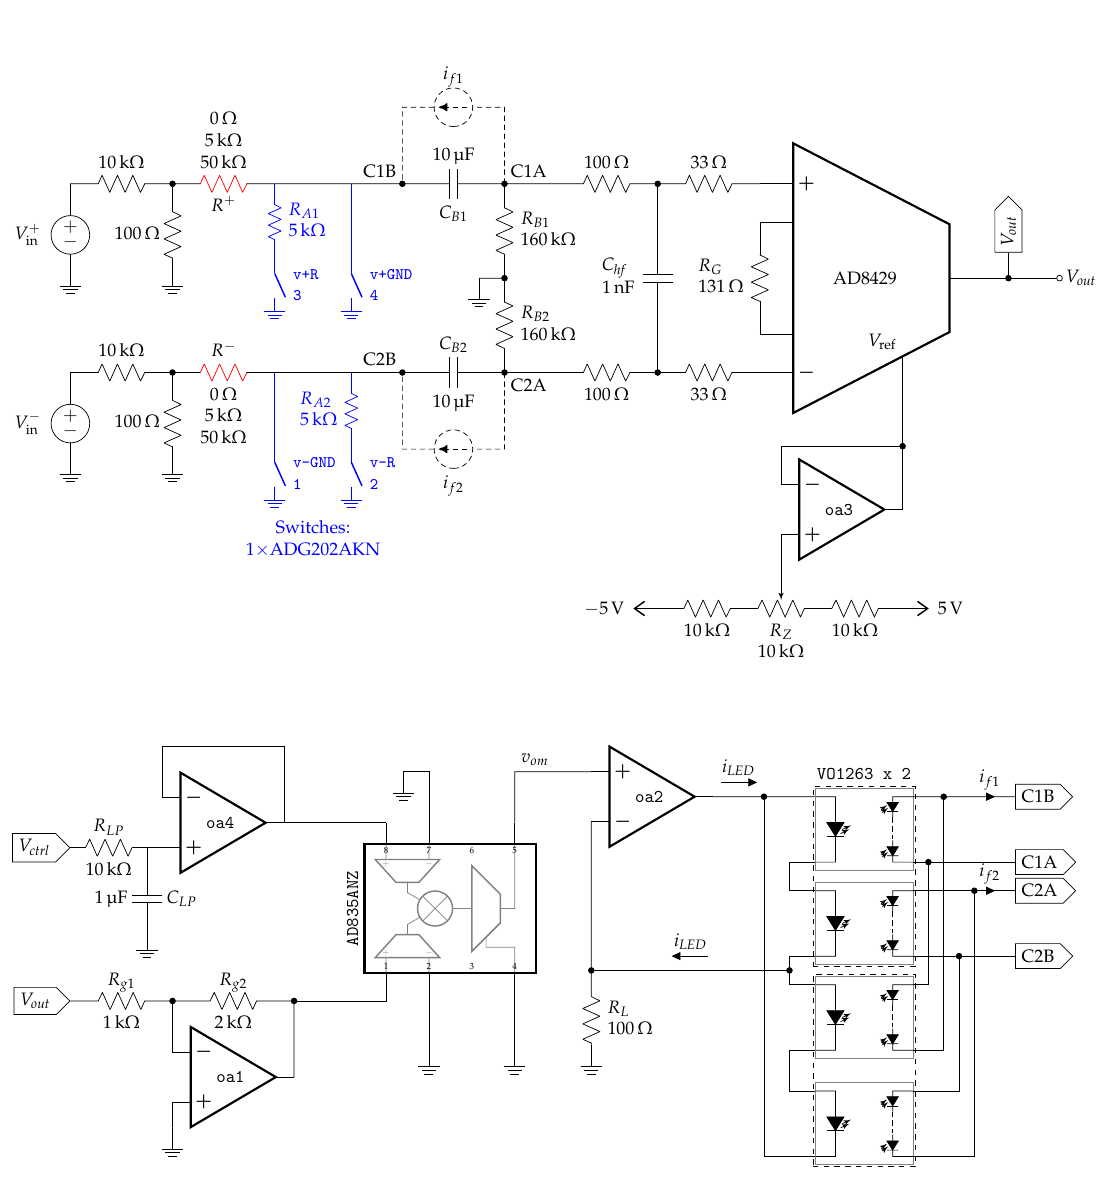
Figure 4. Full circuit used in the tests. The components without labels were added following the suggestions of the respective data sheets, so they are not substantial for the discussion of the behavior. The upper circuit is the main amplifier with the switches used to check the contact impedance, simulated by the R + and R − resistors (together with the equivalent output resistance of the divisor used to reduce the input voltage range). The lower circuit is the FB, consisting of a multiplier, G m , and current injection stage. All the components were supplied with a symmetric